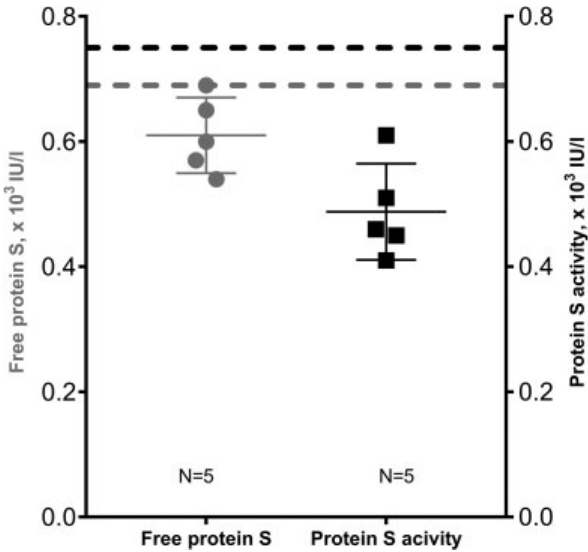
Fig. 3 Free protein S and protein S activity for participants hetero- zygous for the p.(Thr78Met) variant of the PROS1 gene. Gray dots represent participants with free protein S values ( N ¼ 5). The gray broken line indicates the lower reference limit (0.69 (cid:1) 10 3 IU/L) of the free protein S assay. Protein S activity measurements were available for the same fi ve, presented as black squares with the corresponding lower reference limit of 0.75 (cid:1) 10 3 IU/L in the black broken line